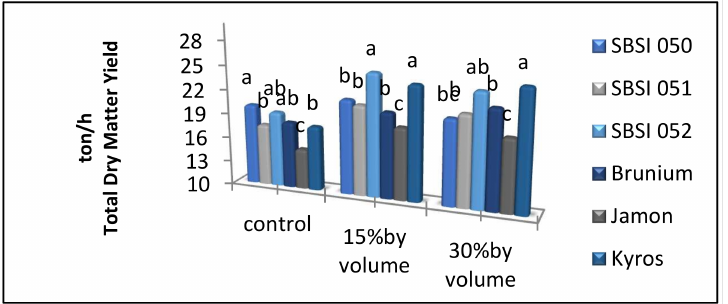
Figure 6. The interaction effects of methanol × genotype on total DM yield. Means followed by the same letter(s) is/are not significantly differ at 5% level of